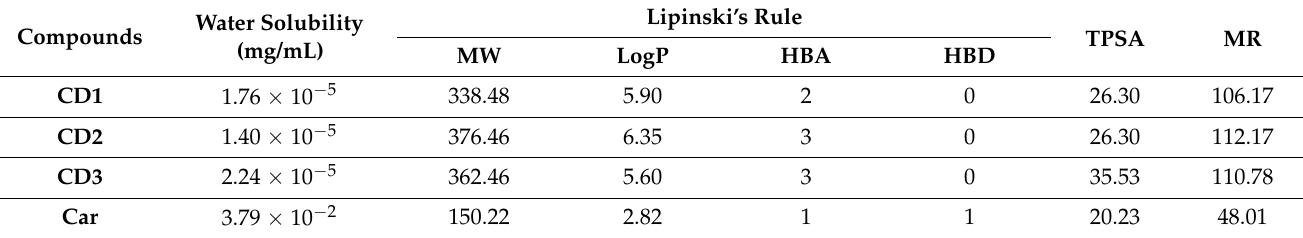
Table 1. In silico evaluation of CD1-3 physicochemical properties a .